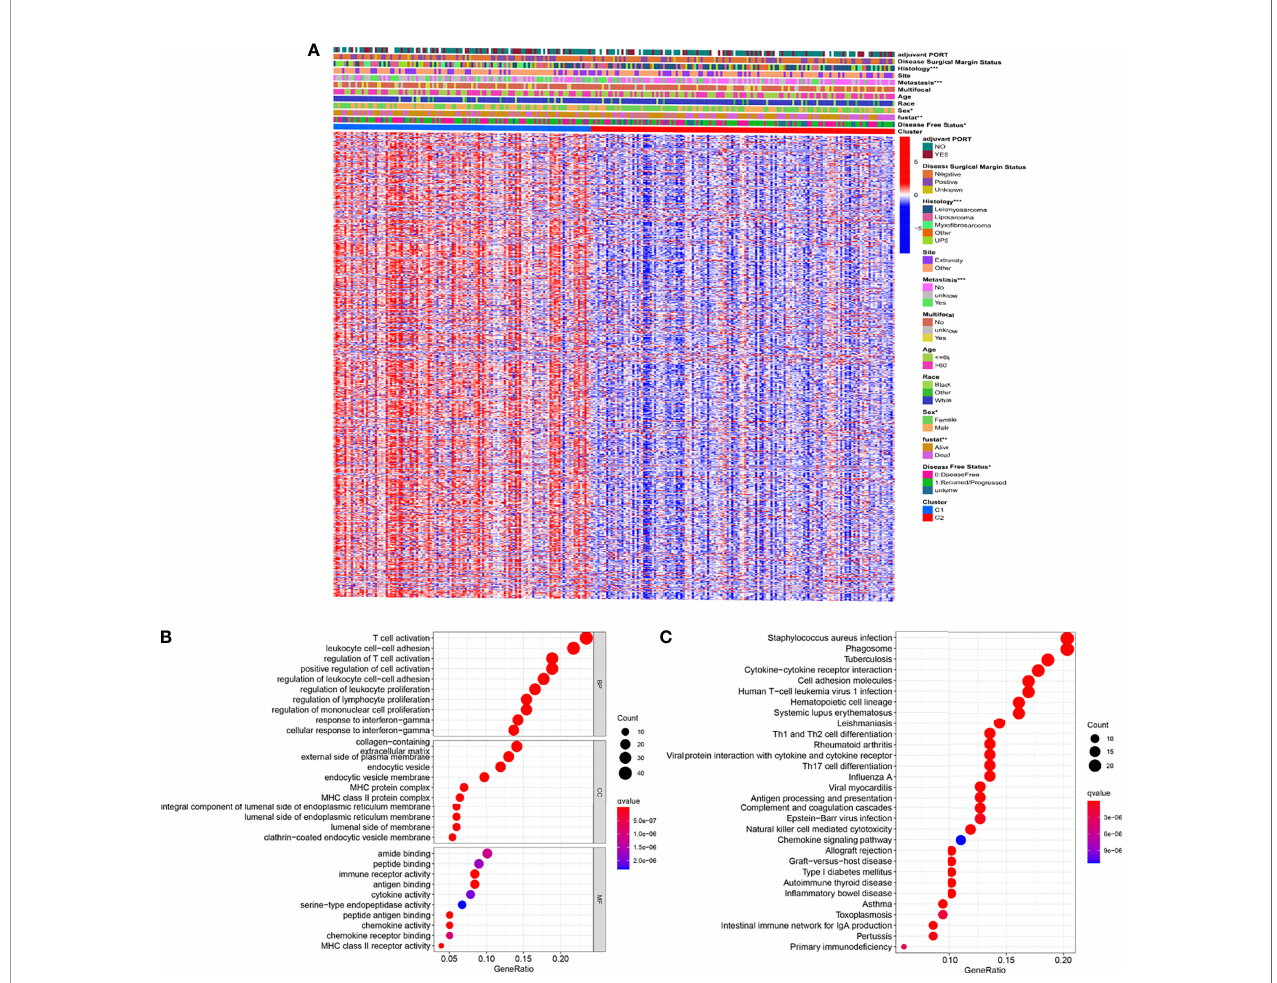
FIGURE 5 | Identi fi cation of DEGs between the two clusters (A) Heatmap showing DEGs and corresponding clinical features (B) GO enrichment analysis including biological process (BP), cellular component (CC), and molecular function (MF). (C) KEGG enrichment analysis indicating related genes and pathways. ns, p ≥ 0.05; *, 0.01 ≤ p < 0.05; **, 0.001 ≤ p < 0.01; ***, 0.0001 ≤ p < 0.001; ****p <